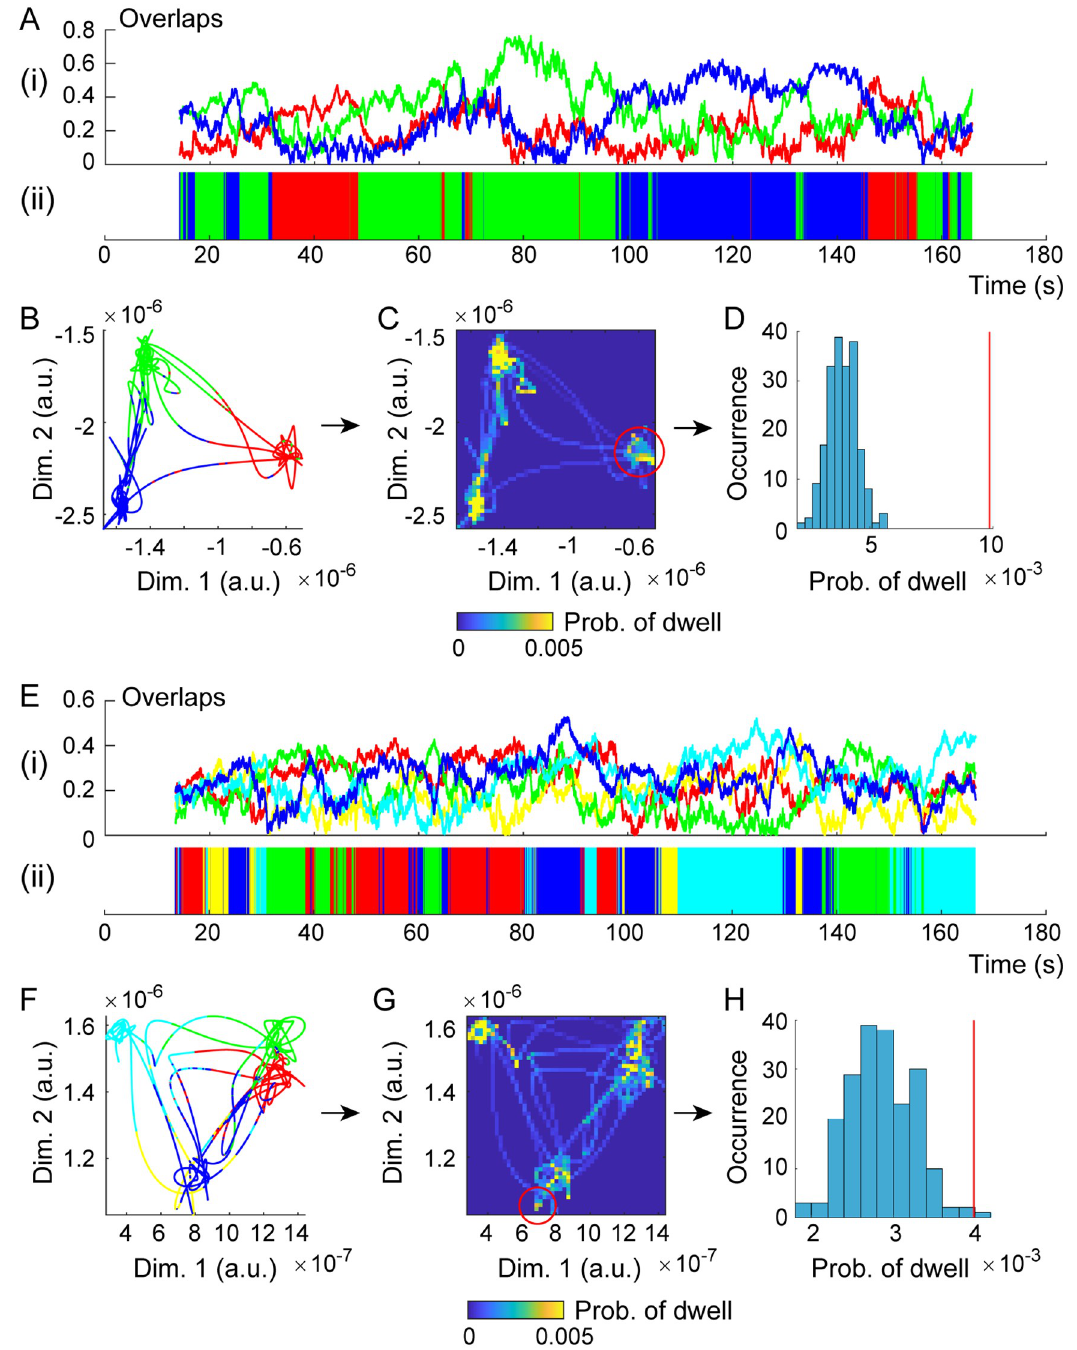
Fig 8. Simulation of delta-alpha PAC dynamics by a coupled oscillator system driven by spontaneous fluctuations. (A to D) The representative simulated delta-alpha PAC dynamics for an individual with higher attention-related AQ subscores (refer to Fig 4A to 4E). (E to H) Representative dynamics for an individual with lower scores (refer to Fig 4F to 4J). (A, E) Time courses of overlaps (i) and the corresponding labels (ii) among delta-alpha PAC states. (B, F) The trajectory of labeled signals in a plane. (C, G) The corresponding bivariate histograms. (D, H) Surrogate data testing under condition d = 2. Surrogate data testing was applied to the density of points indicated by the red circles in panels C and G and the red lines in panels D and H, and the null hypothesis H 0 in condition d = 2 was rejected (D and H). The model showed consistent results with the data analysis, evidence of the dynamic PPC-PAC hypothesis.